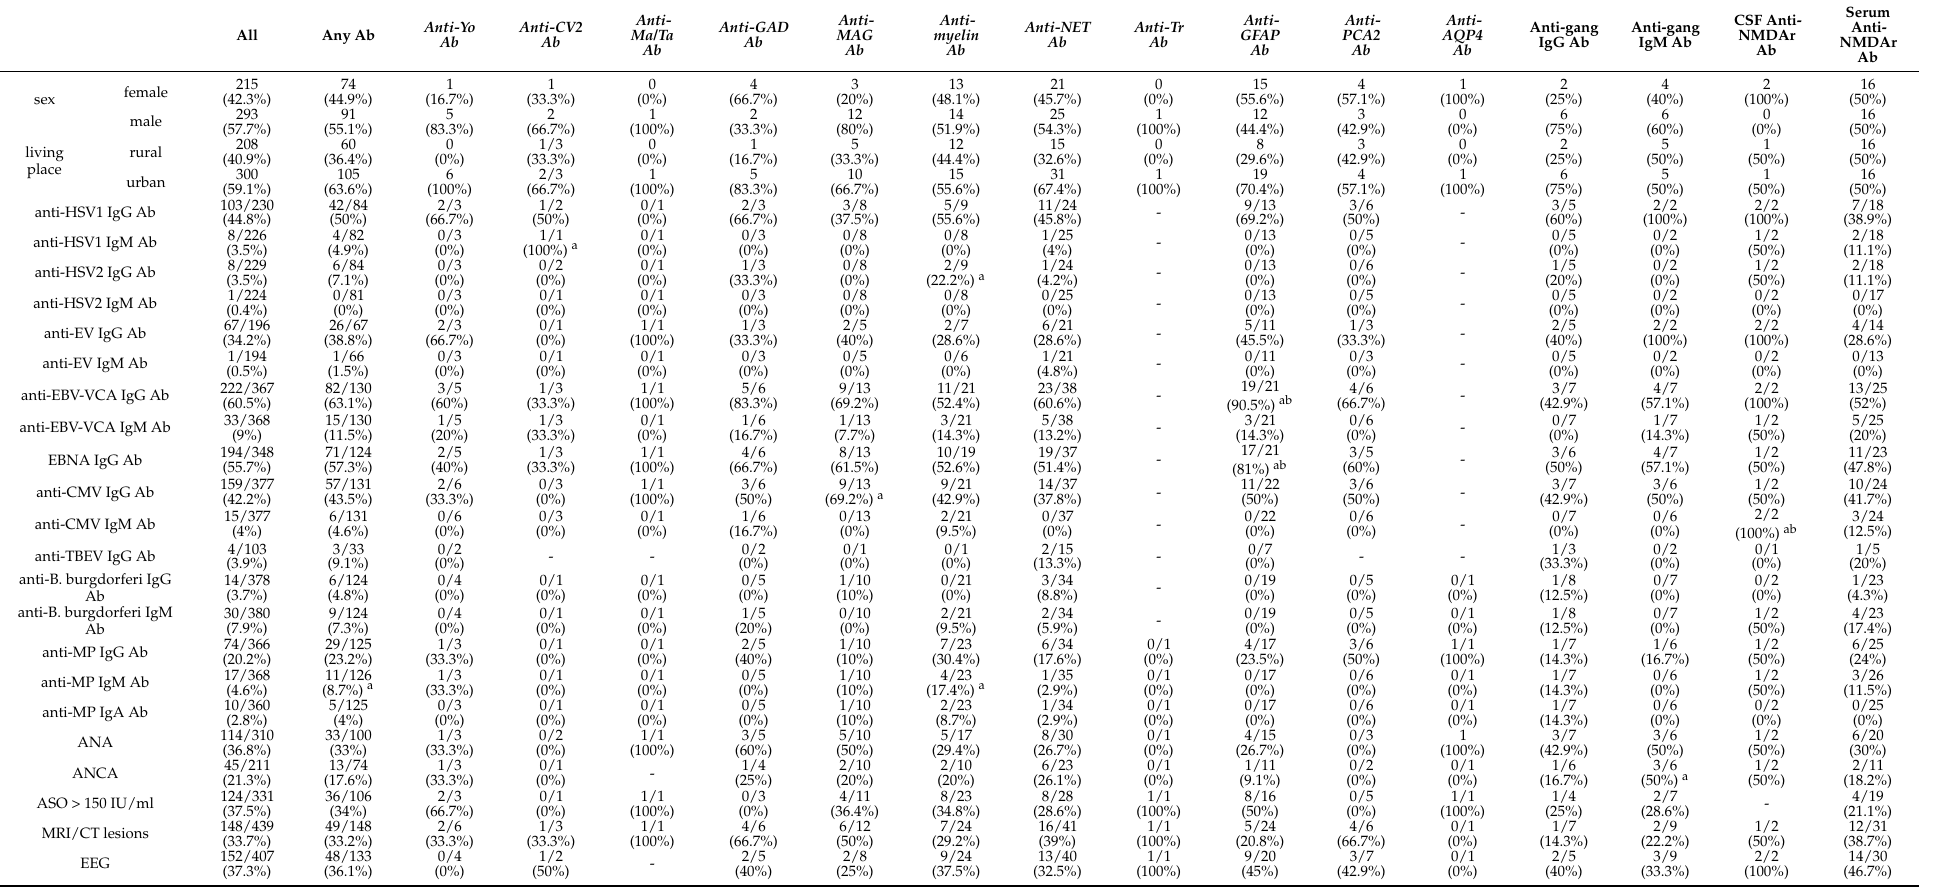
Table 4. The frequency and positivity percentage in the entire group, in the autoantibody-positive population and with specific